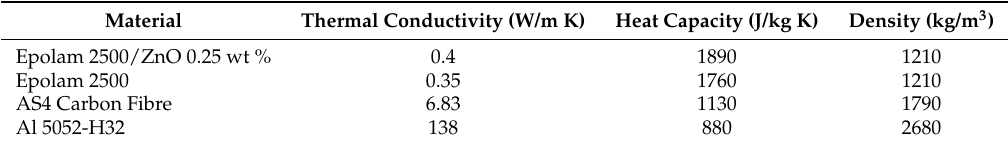
Table 2. Thermal properties of the materials